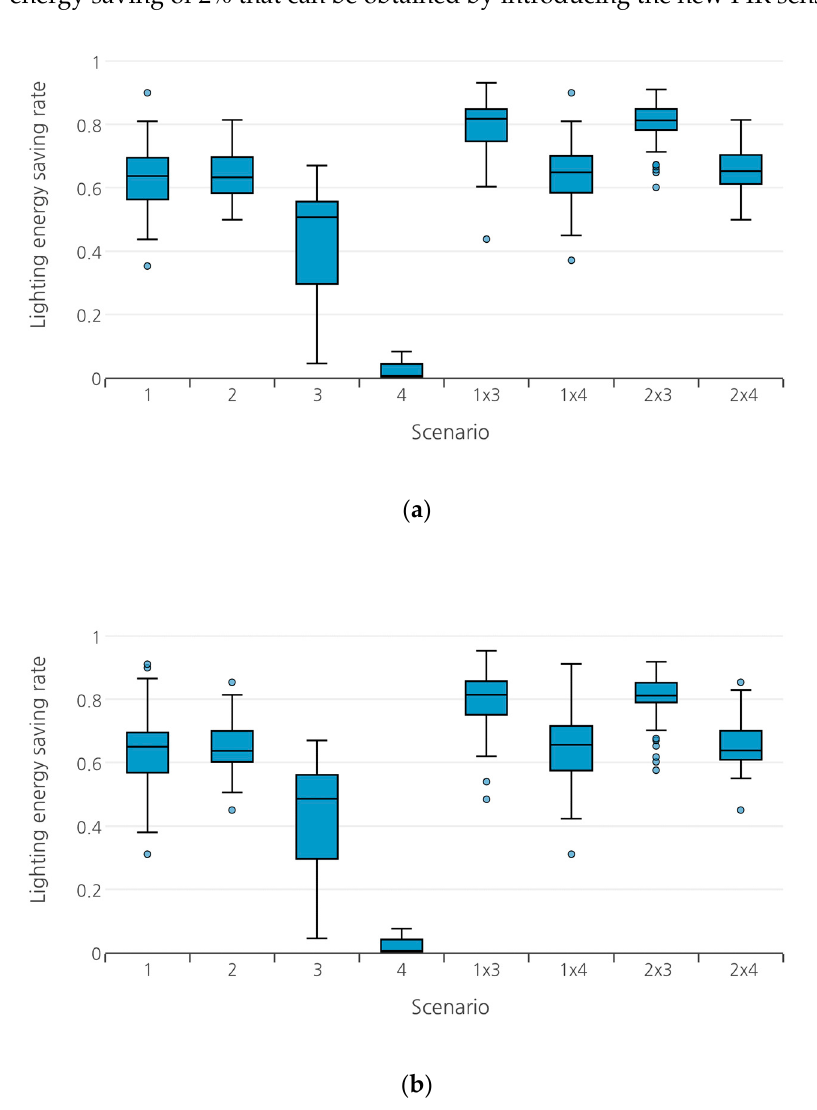
Figure 6. Box plots of energy savings for the scenarios: ( a ) first semester ( n = 54); ( b ) second semester ( n = 53).